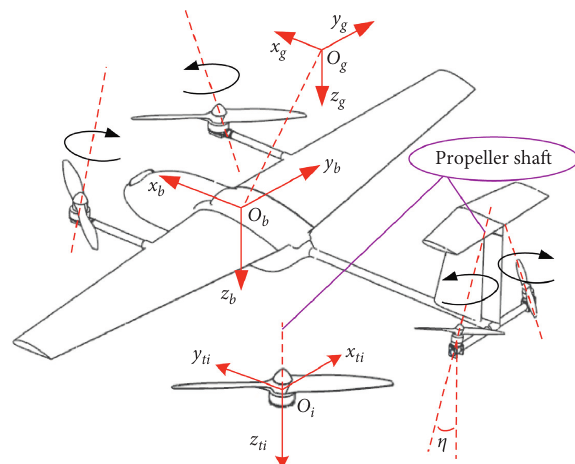
Figure 2: TRUAV structure and coordinate